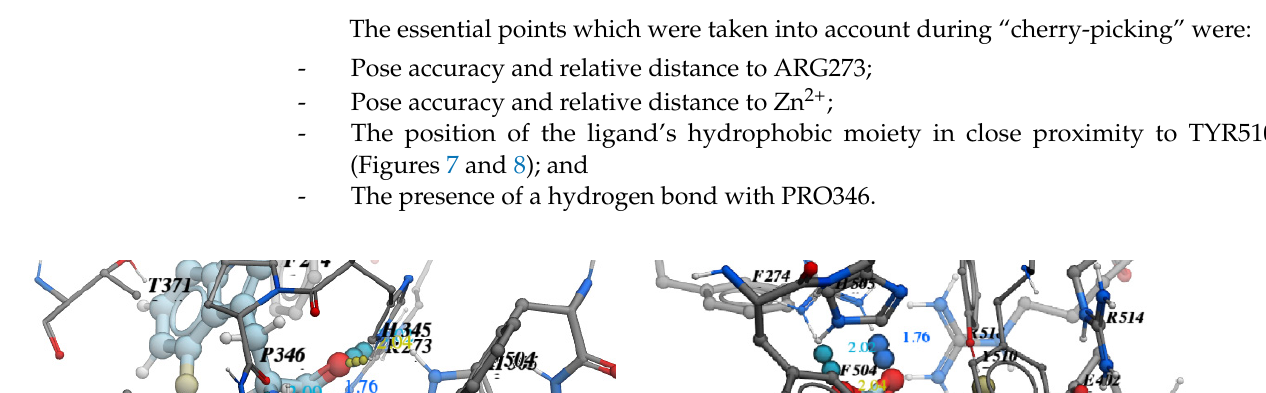
Figure 6. Virtual screening workflow for Enamine SCC (3.2 million compounds).